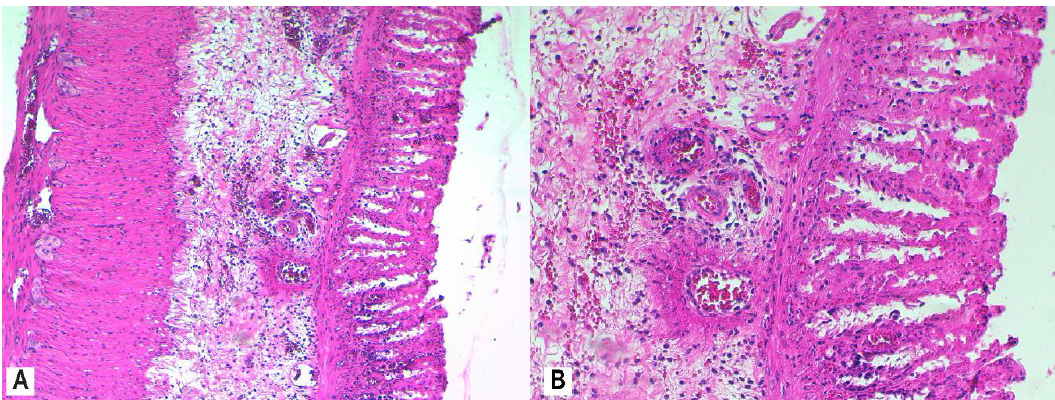
Figure 10. Colon histology of rats administered MP (AA + MP group). Colon tissue of rats that were administered MP for 11 consecutive days prior to AA exposure was collected 24 h after AA exposure and demonstrated moderate inflammatory infiltrate in the mucosa and submucosa, absence of neutrophils in the lamina propria, neutrophil infiltration of crypt epithelium in <5% of crypts, marked recovering luminal epithelium, and increased crypt density and restoration of intestinal crypt architecture; H&E stain, 10× ( A ), 20× ( B ). Abbreviations: AA, acetic acid; H&E, hematoxylin and eosin; MP, methylprednisolone.